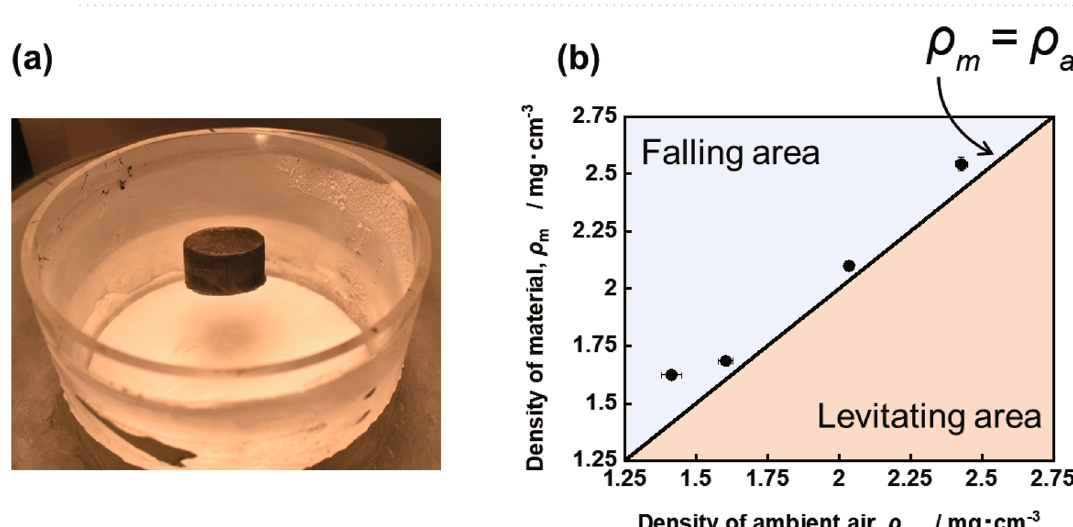
Figure 4. Results of the levitation experiments with ultralight aerogels of various densities. ( a ) Optical image of an aerogel during levitation. ( b ) Relationship between the density of the sample during levitation and that of ambient air. The ultralight material levitates in the range where ρ a > ρ m . (The plots are the average of three measurements, and the error bars represent standard